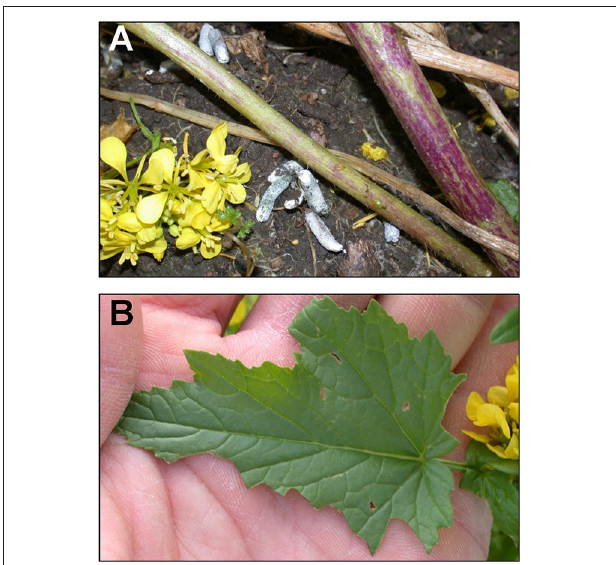
FIGURE 2 | Soil surface under a mustard cover crop canopy (A) with foliage-rich sparrow droppings. Mustard ( Sinapis alba) leaf (B) that has been fed on by a sparrow, presumable the White-crowned sparrow. Note the edge toward the top of the photo is mostly intact, whereas the edge toward the bottom has jagged edges indicating bird